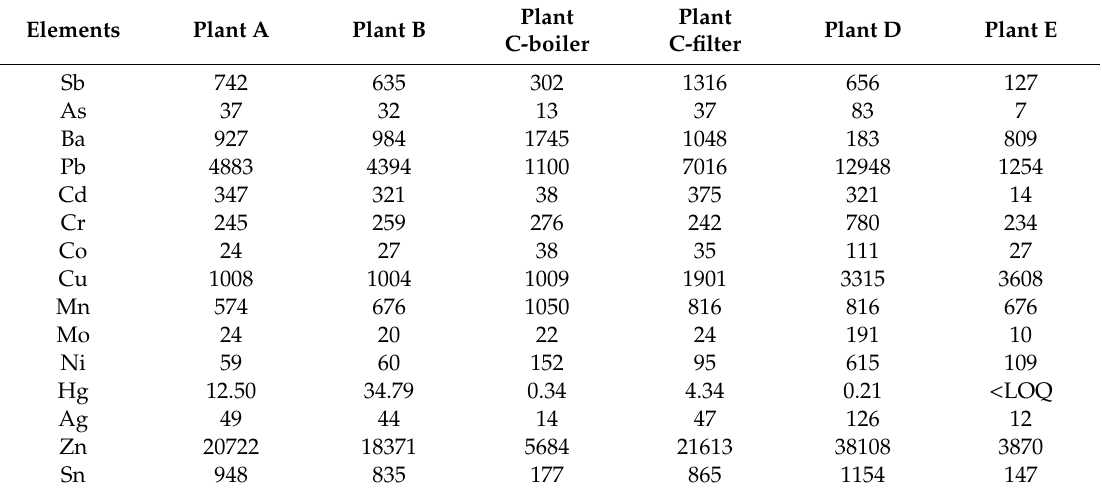
Table 4. Total content of nonmatrix elements in di ff erent fly ash samples determined by ICP-OES given in mg / kg, where LOQ = limit of